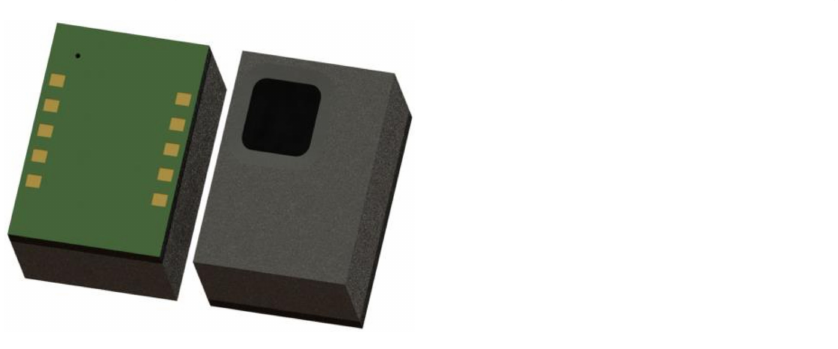
Figure 3. Vacuum Packaged Digital TMOS with Organic Land Grid Area (LGA) with Surface Mount Technology (SMT). The packaged device dimensions: 3.2 × 4.2 × 1.45 mm 3